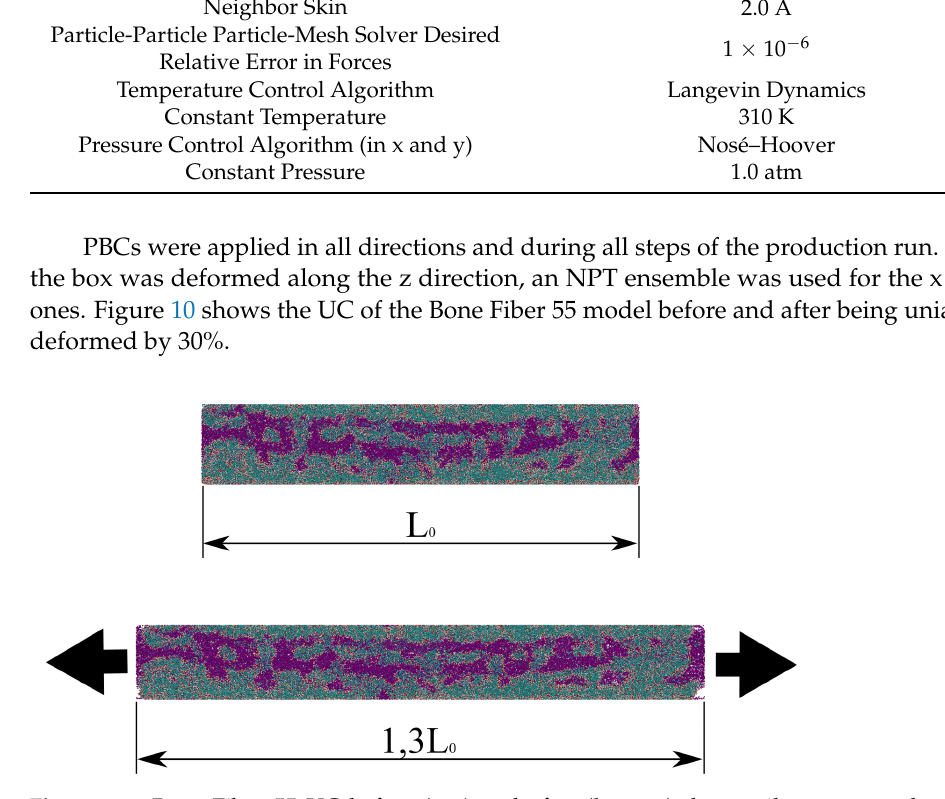
Figure 10. Bone Fiber 55 UC before ( top ) and after ( bottom ) the tensile test; snapshots from OVITO [66]. The arrows indicate the stretching